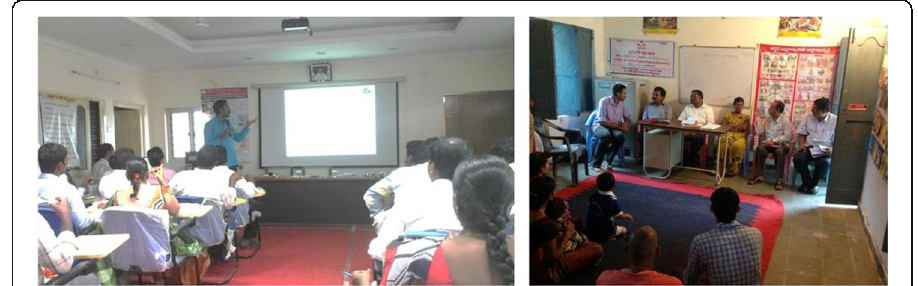
Fig. 11 Training for teachers on the usage of our platform [left] and field visit to Harshaguda Village, Hyderabad, India